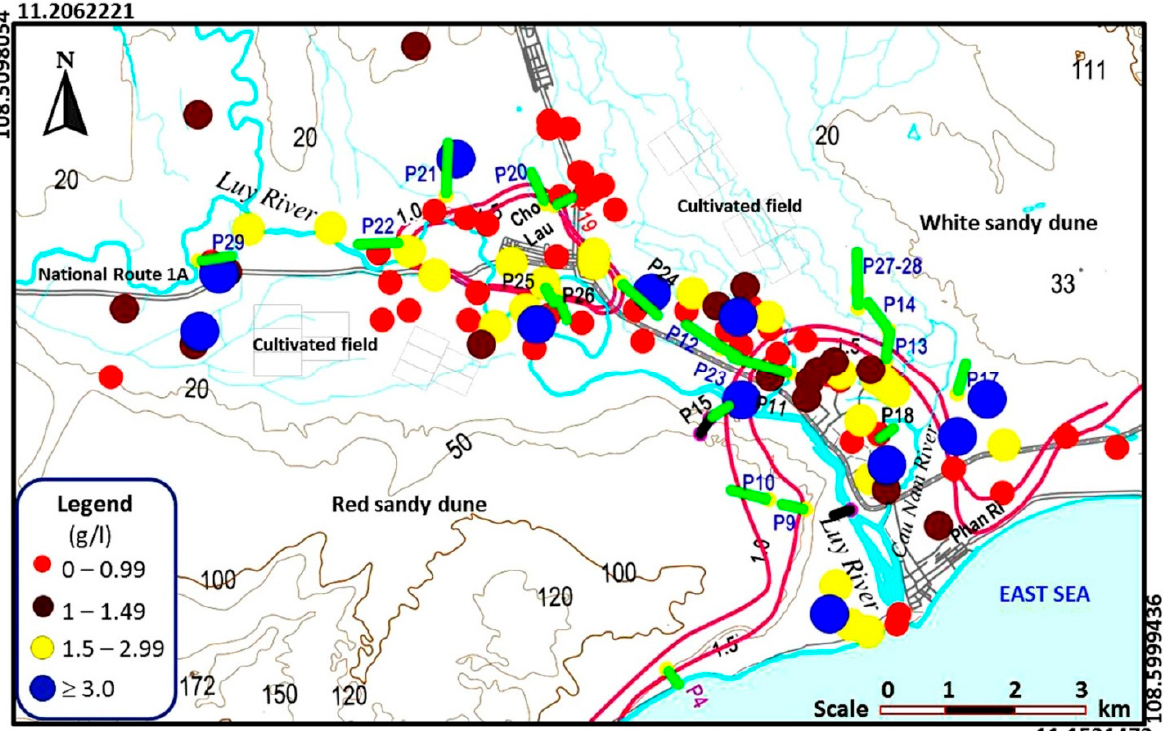
Figure 4. Relationship between resistivity and the lithological composition of boreholes. The low resistivity features are characterized by higher clay content in both saturated and fractured zones. Note that Qh, Qp are Holocene and Pleisto- cene aquifers, respectively; K refers to Deo Ca Cretaceous granite complex. The same notation is used in the following figures.